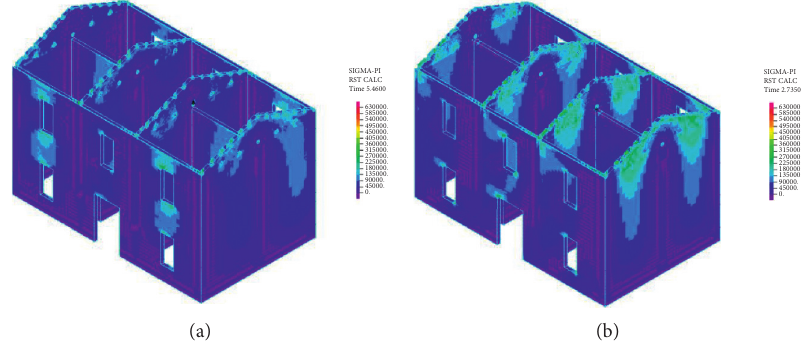
Figure 13: Cloud diagram of the maximum main tensile stress of the wall under the Loma Prieta earthquake (0.2g). (a) X -direction. (b) Y